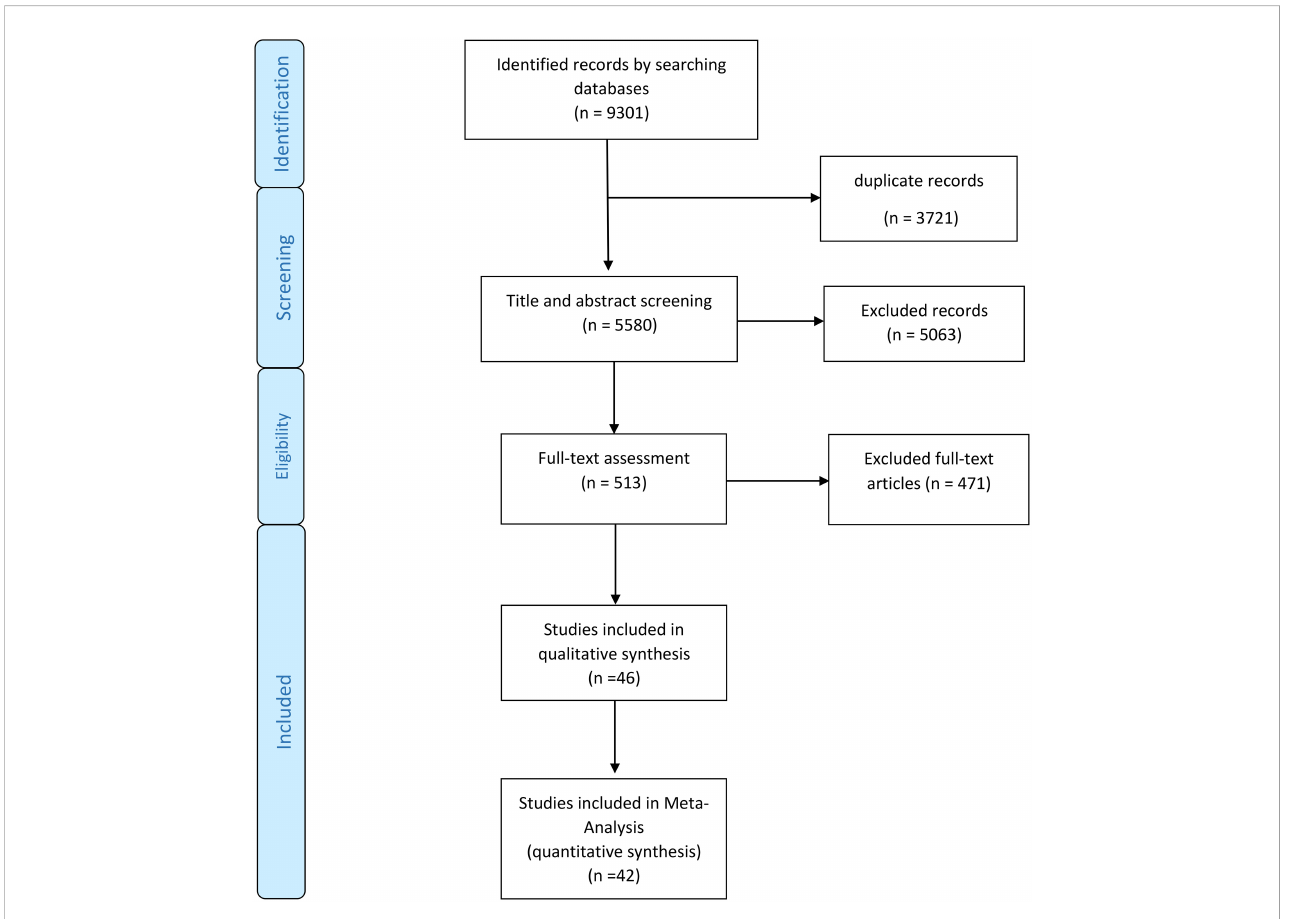
FIGURE 1 Studies search, review and analysis fl